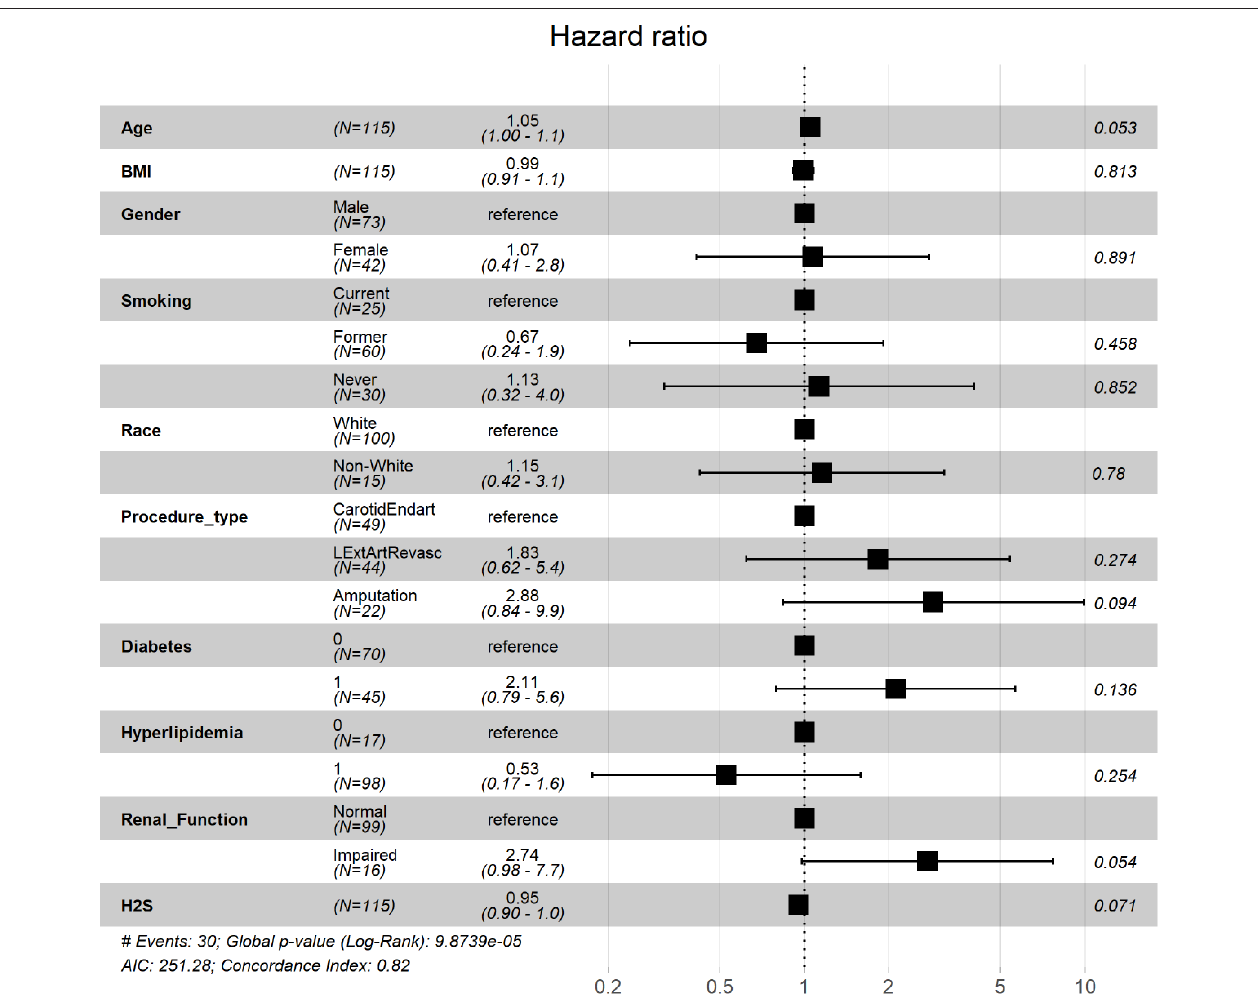
FIGURE 2 | Hazard ratios of death during follow up period. Hazard ratio estimates and 95% confidence intervals for clinically relevant parameters and plasma H 2 S production capacity as measured by the lead acetate release